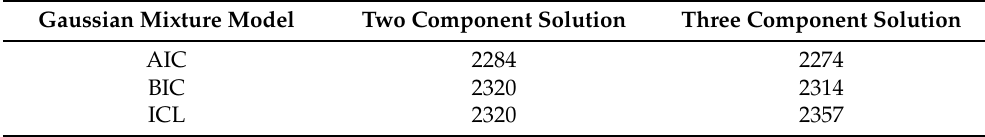
Table 1. Values of BIC for estimated Gaussian mixture model with different numbers of components. Gaussian Mixture Model Two Component Solution Three Component